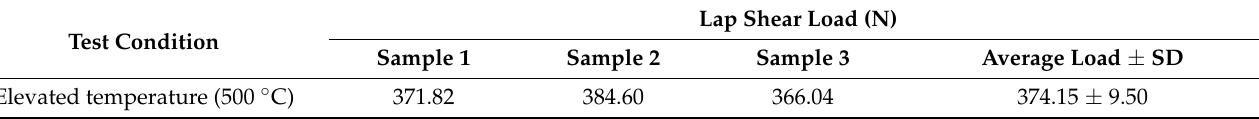
Table 8. Lap shear test of welds with 6 spots at elevated temperature.